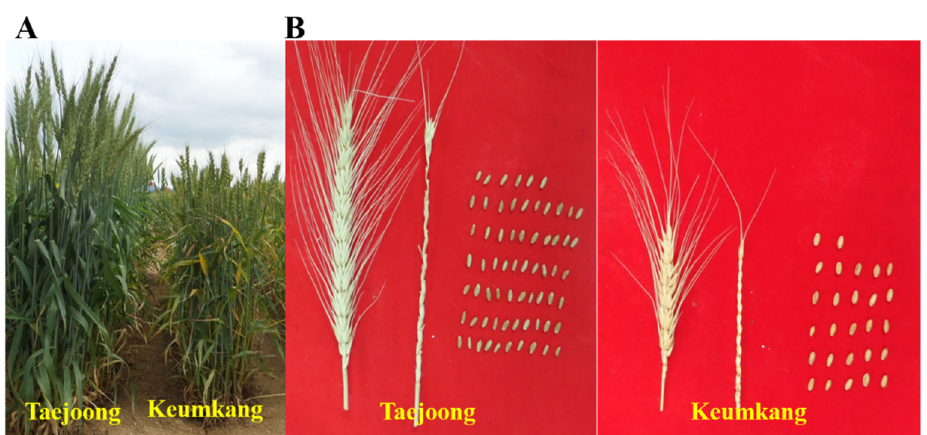
Figure 1. Phenotype comparison of Taejoong and Keumkang: ( A ) plants at heading, and ( B ) spike, rachis, and kernels per spike after maturity.